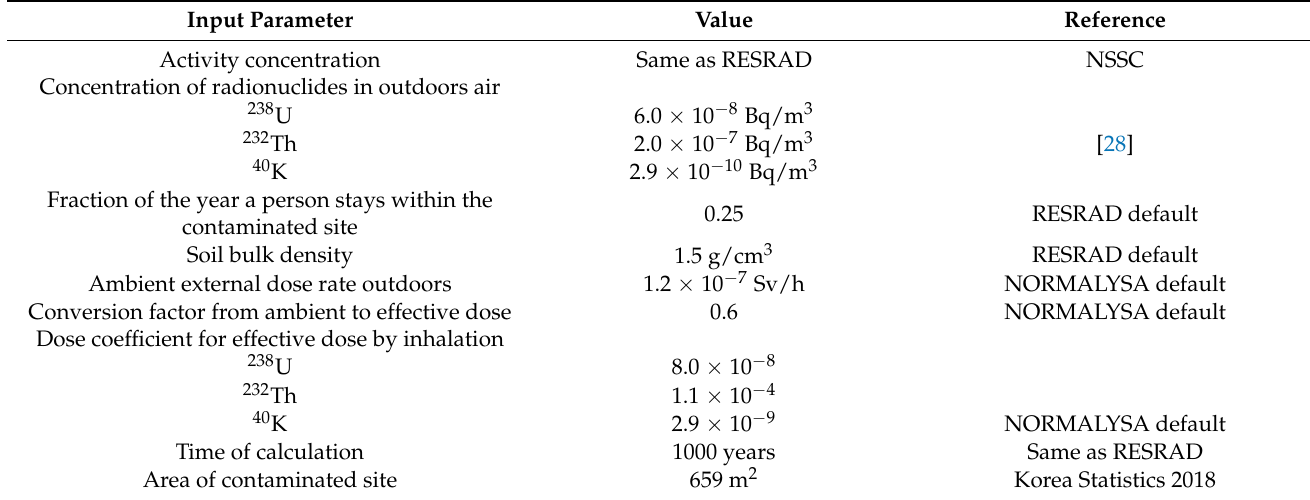
Table 6. Summary of NORM and LegacY Site Assessment input